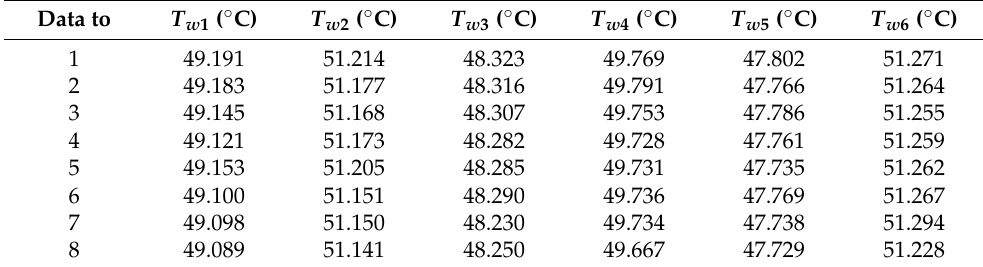
Table 1. Tube surface temperature data from the baseline test at a flow velocity of 0.4